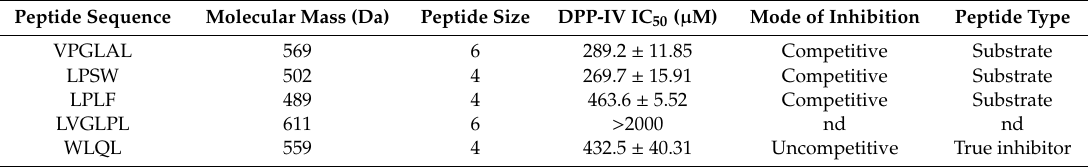
Table 3. Summary of Dipeptidyl peptidase (DPP)-IV inhibitory peptides derived from SSTY GI protein. Peptide Sequence Molecular Mass